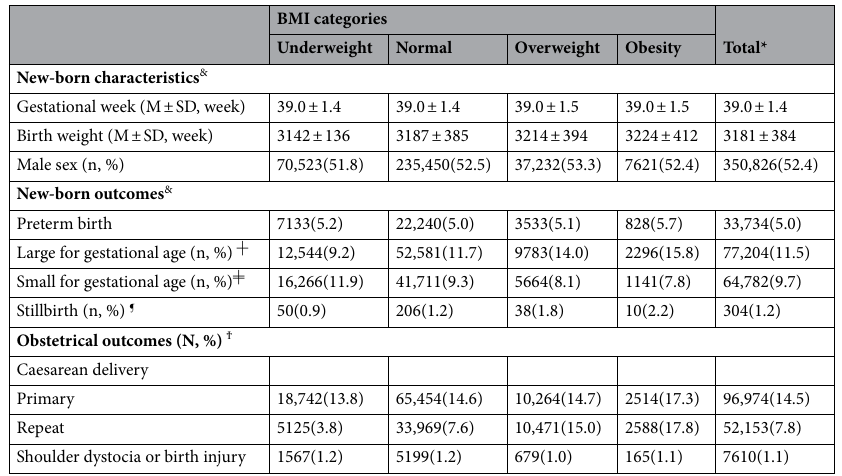
Table 2. Characteristics of the new-borns and frequency of outcomes with respect to pre-pregnancy BMI. ┼ Birth weight above the 90th percentile for gestational age by infants’ sex; ╪ Birth weight below the 10th percentile for gestational age by infants’ sex; & Total number of participants is 669,101; ¶ Total number of participants is 256,882; Ϯ Total number of participants is